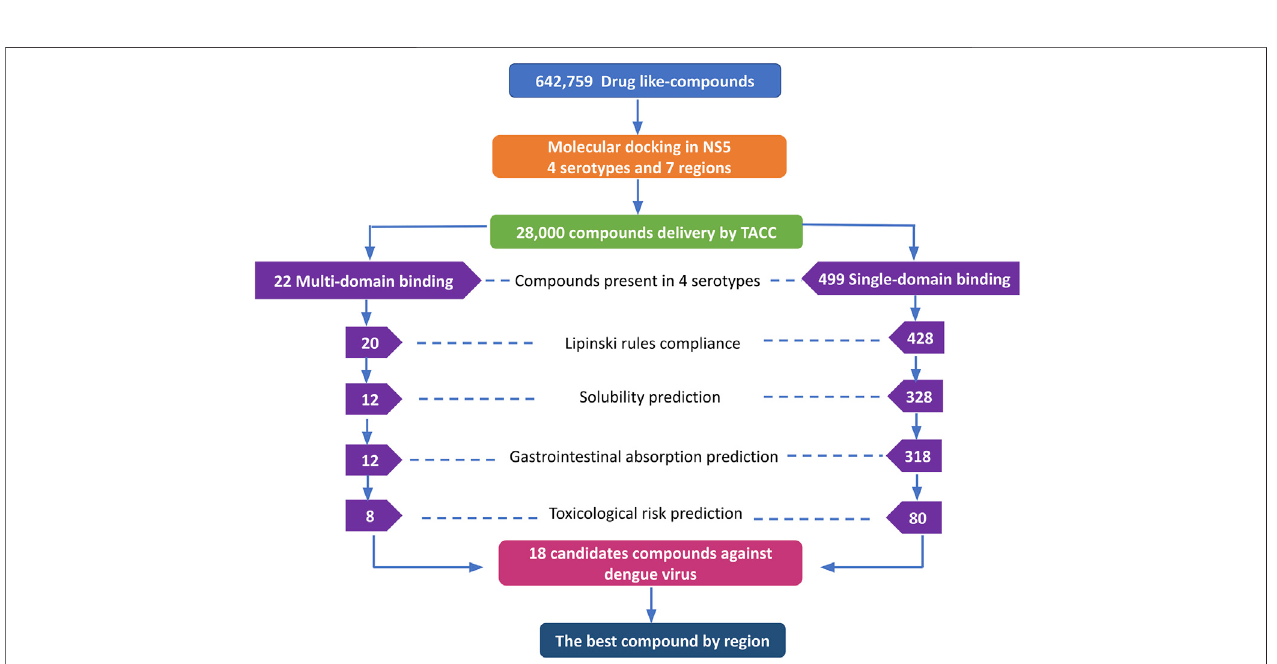
FIGURE 2 | Work fl ow of the virtual screening of drug-like compounds with possible multi-domain and single-domain binding, as potential candidates for in vitro experimental assays against the NS5 protein of DENV. Candidate compounds against the NS5 protein of DENV.